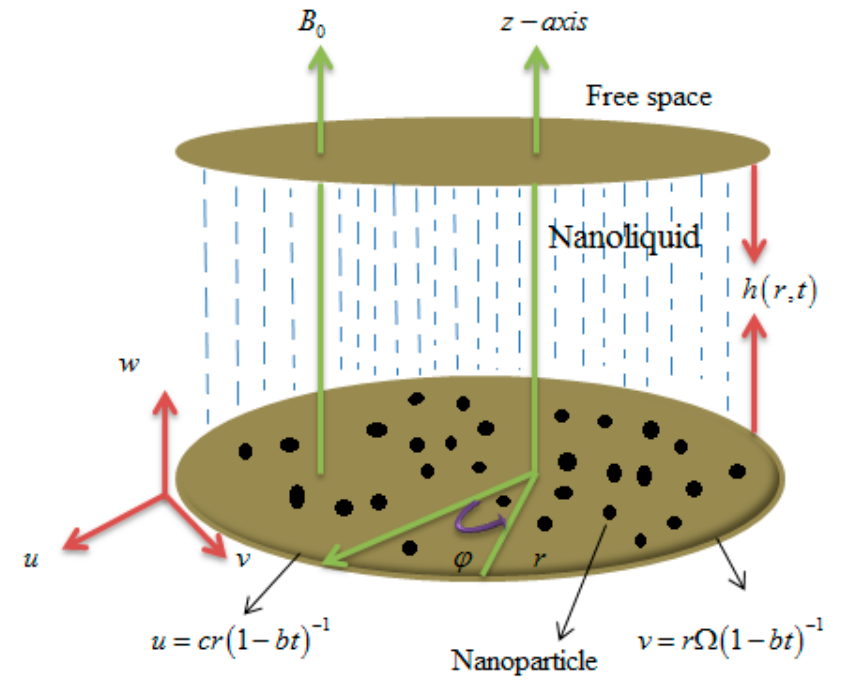
Figure 1. Physical sketch of the problem.